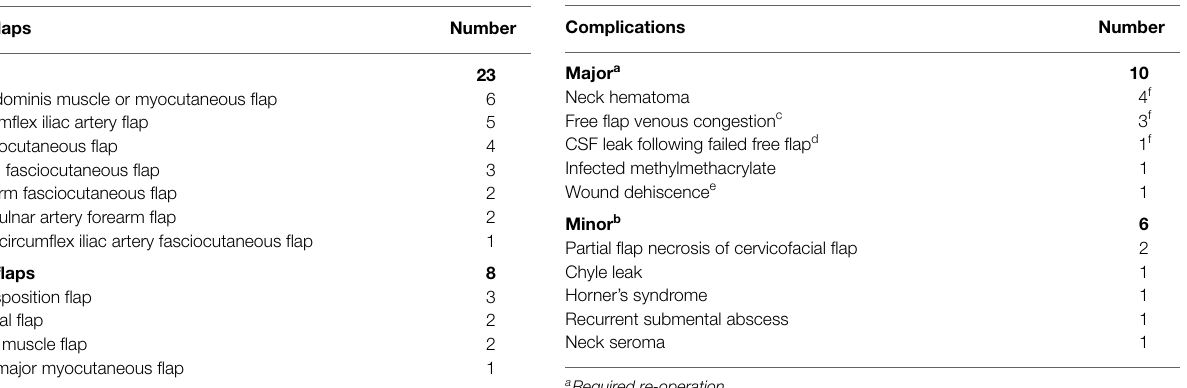
TABLE 3 | Complications in 11 patients